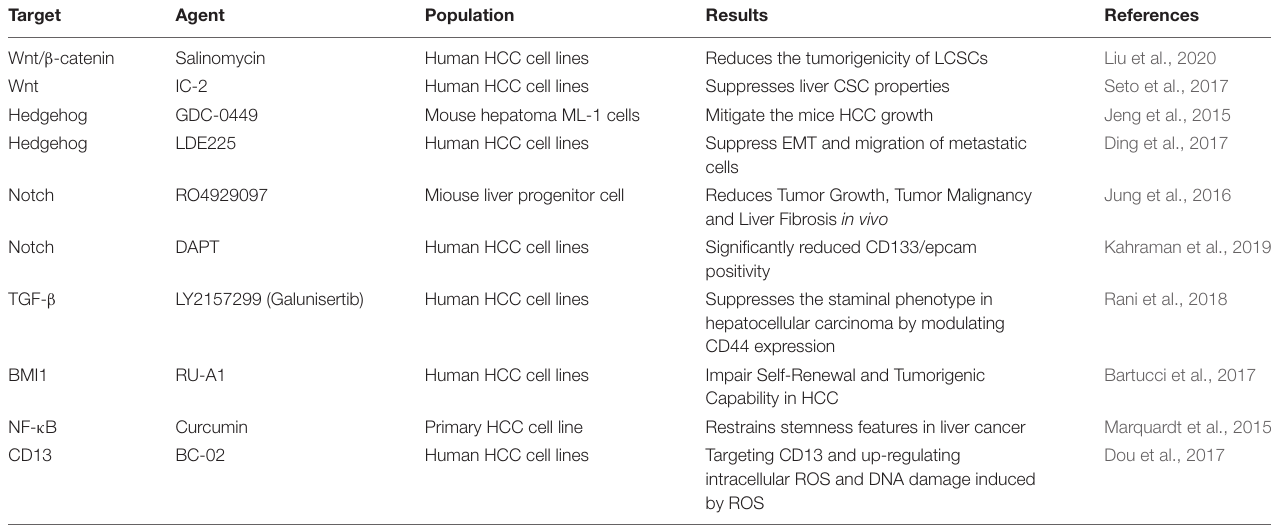
TABLE 2 | Summary of various agents in research development to target LCSCs